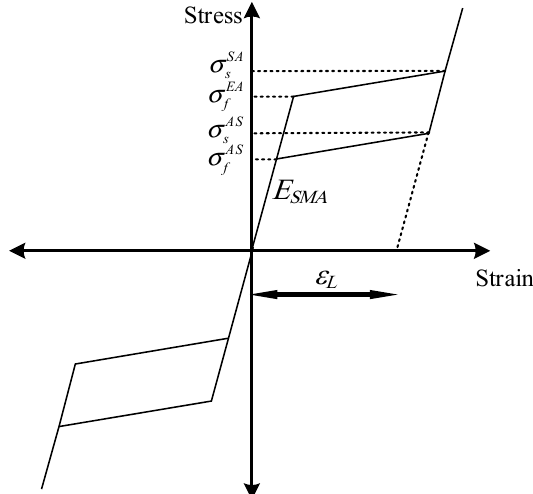
Figure 2. Stress–strain model of SMAs with superelasticity feature [81].